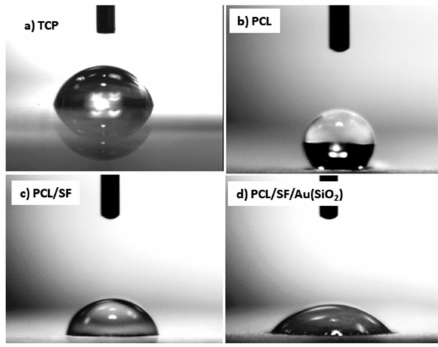
Figure 3. Water contact angle of ( a ) TCP ( b ) PCL ( c ) PCL / SF and ( d ) PCL / SF / Au(SiO 2 )